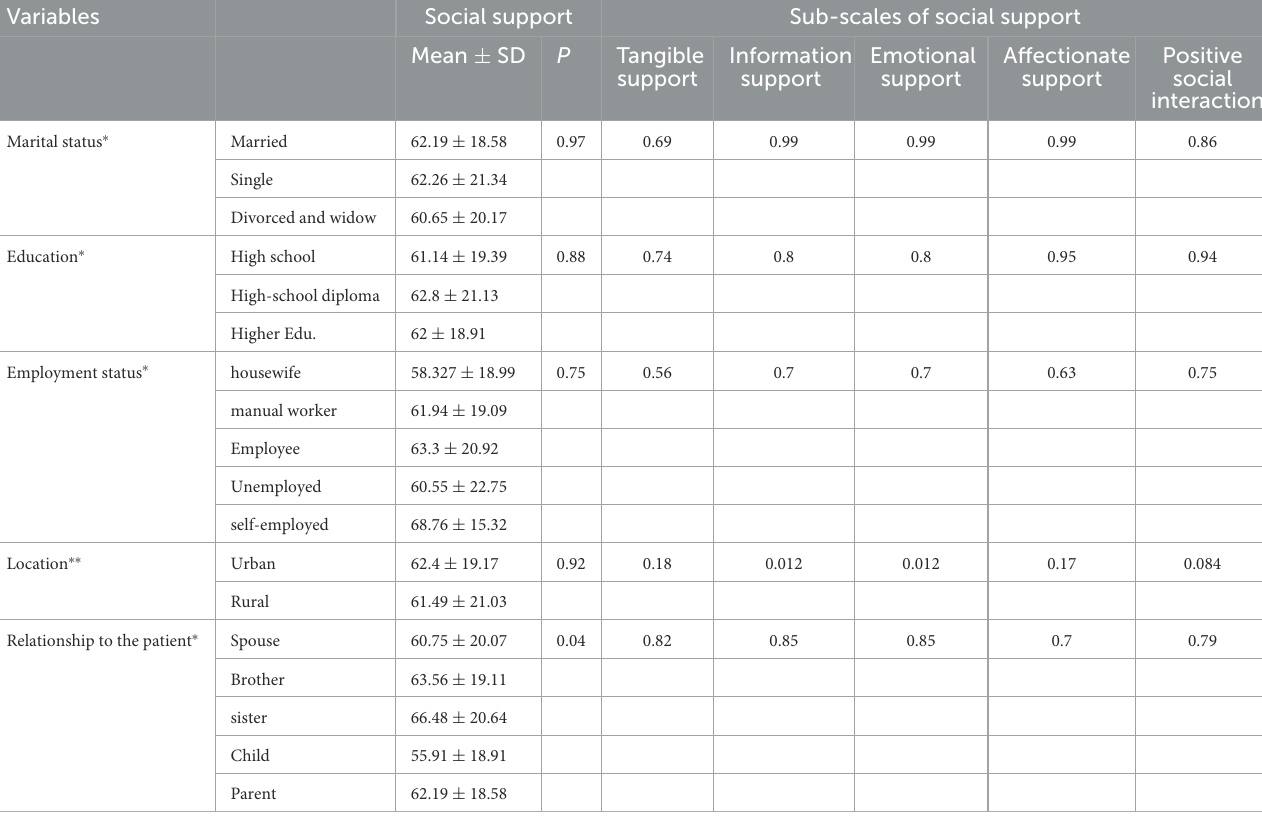
TABLE 4 Relationship between social support and its subscales with demographic variables of research units in quantitative study section.